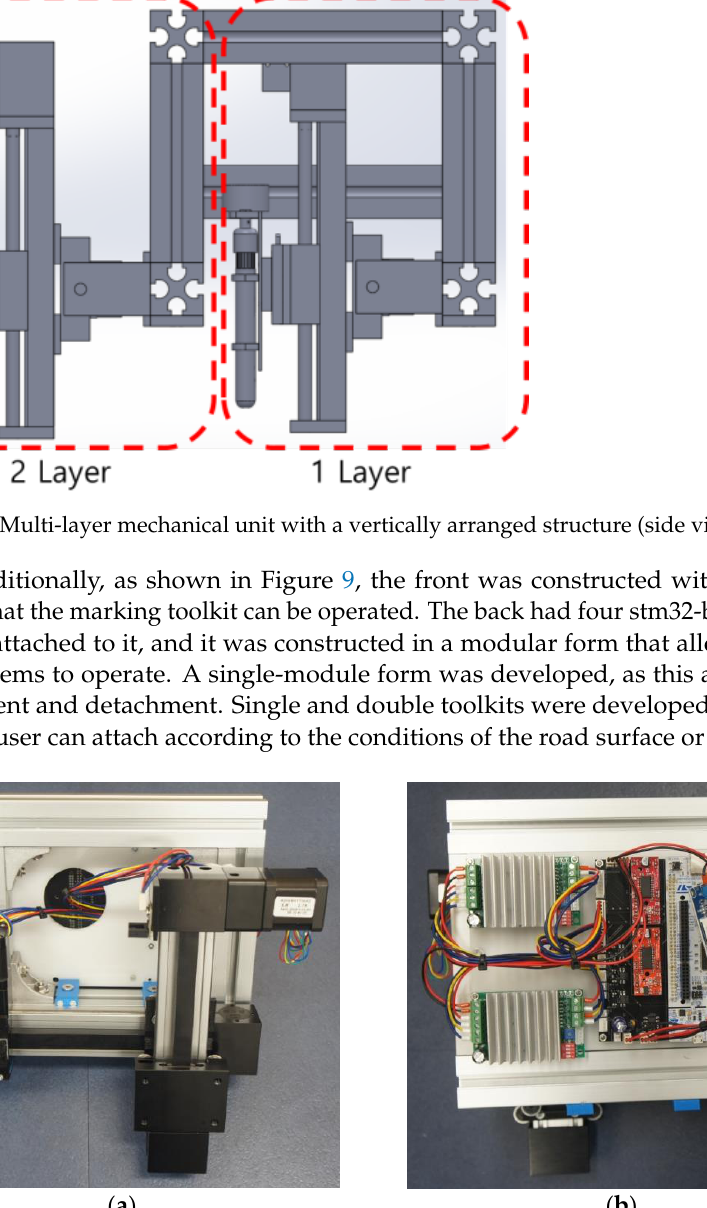
Figure 9. Multi-layer mechanical unit with a modular form: ( a ) front view of the multi-layer mechanical unit and ( b ) plane view of the multi-layer mechanical unit.